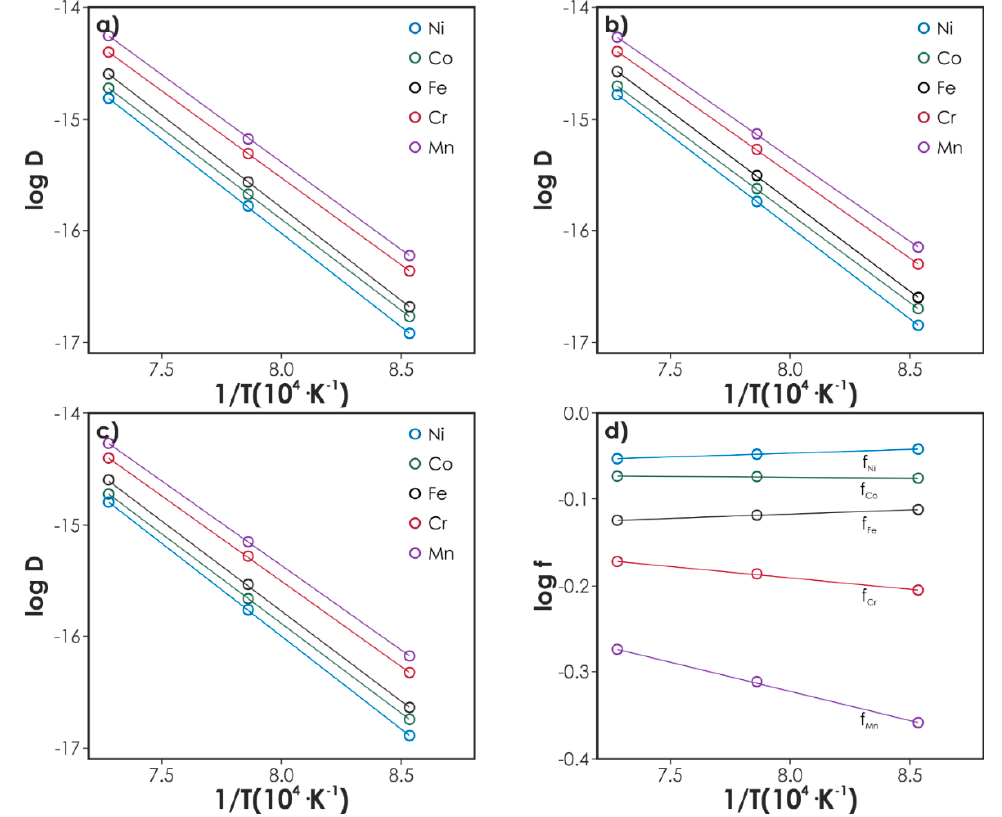
Figure 30. Self-diffusion coefficients calculated, based on the experimental data by Tsai et al. [28], with the use of three different approaches: ( a ) Darken, ( b ) Manning-Holdsworth-Elliot, ( c ) light Moleko-Allnatt-Allnatt (MAA). d ) Correlation factors for the self-diffusion coefficients calculated by the MAA-light approach (after [50]). Reprinted from Materials Chemistry and Physics (2018), Analysis of diffusion in high entropy alloys, 193–207, Copyright 2018, with permission from Elsevier.